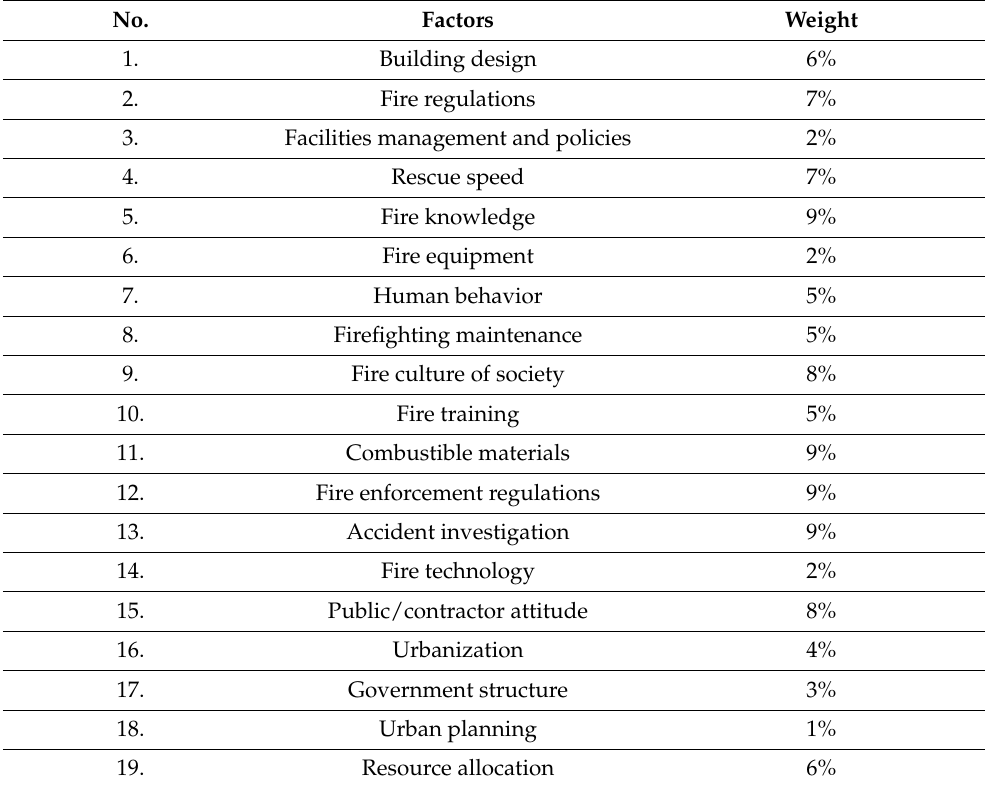
Table 3. General factors effecting the fire management system in the Emirate of